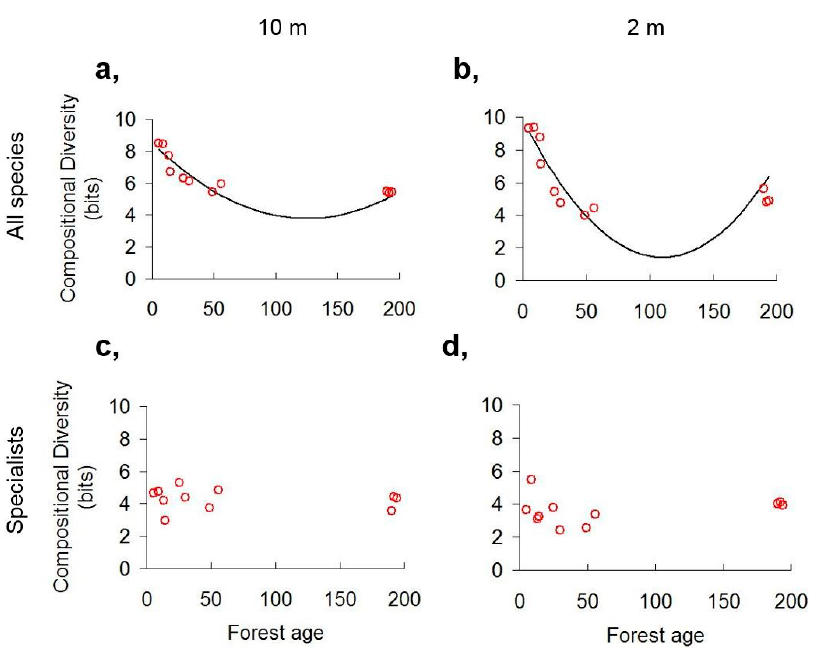
Figure 2. Beta diversity along the chronosequence represented by Compositional Diversity. Significant quadratic models are shown. (a). For all species at 10 m scale: Y = 0.0003 x 2 − 0.0752 x + 8.4953 (R 2 = 0.855 p < 0.001). (b). For all species at 2 m scale: Y = 0.0007 x 2 − 0.1539 x + 9.892 (R 2 = 0.8627 p < 0.001). (c)(d) show non ‐ significant relationships.